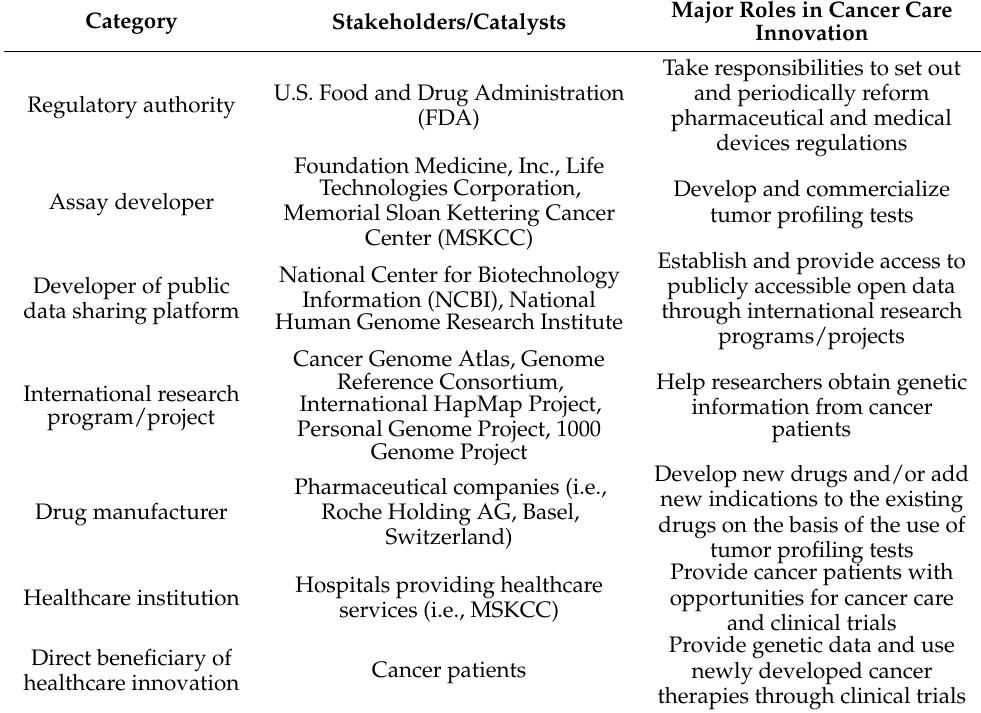
Table 1. Major stakeholders and